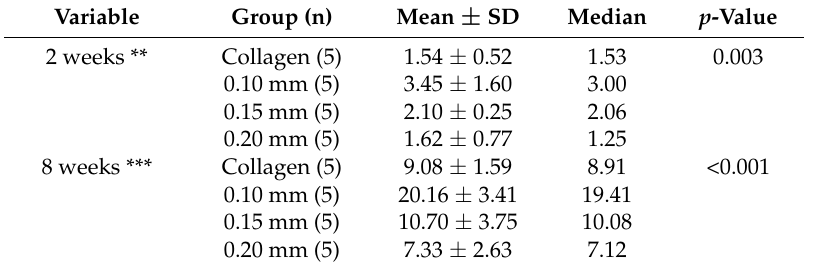
Table 1. Mean ( ± SD) of neo-tissue (NT)/new-bone (NB) area (%) of groups at 2 and 8 weeks after surgery.